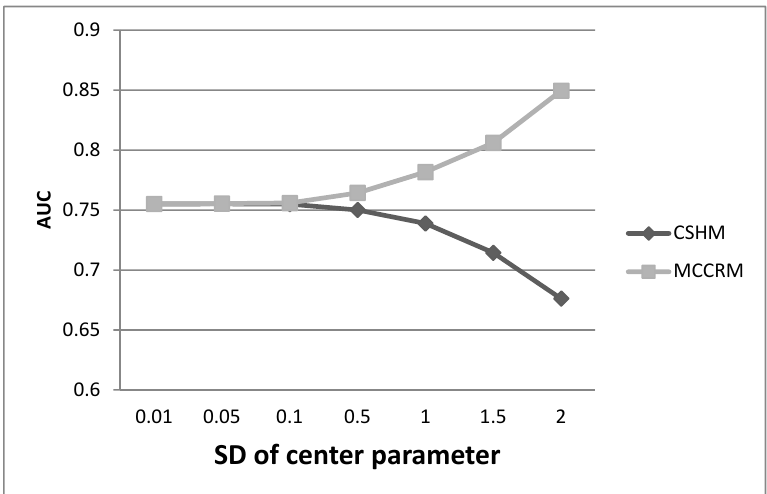
Figure 1. Comparison of the MCCRM and CSHM. Seven discrete points of standard deviation of the center parameter were specified for the simulations. AUC: area under the curve.